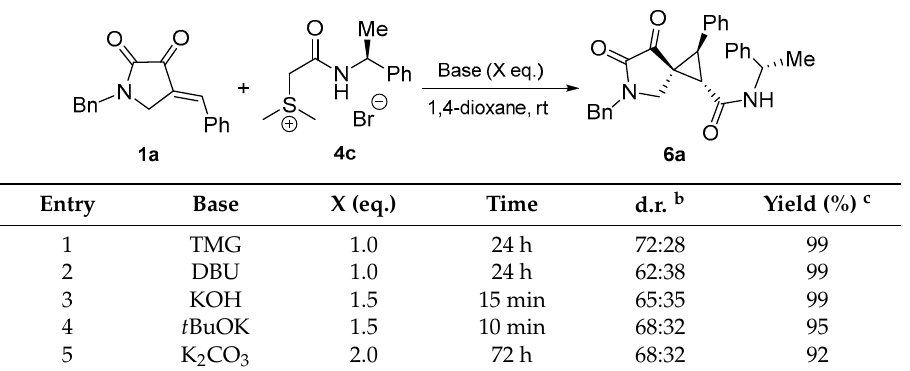
Table 4. Optimization of reaction condition for the synthesis of chiral spirocyclopropane 6a a .